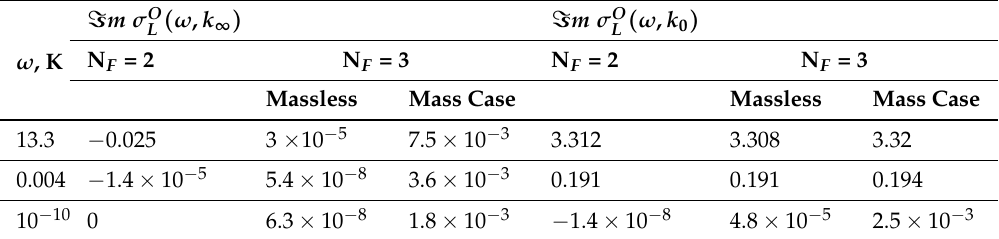
( ω , k ) for the massless pseudo Dirac fermion graphene model is a The function (cid:61) m σ O L (cid:12) ( k ) ≡ (cid:61) m σ constant function (cid:61) m σ O (cid:12) k ∞ at large wave numbers. The L k → ∞ < 0) for the frequencies ω = 0.004, 13.3 K and a zero-values function constant ( (cid:61) m σ k ∞ = 0) at ω = 10 − 10 K (see Table 1 and Figure 4). However, the imaginary part of ( (cid:61) m σ k ∞ the longitudinal complex conductivity in the N F = 2-model becomes a positive constant (cid:12) ≡ (cid:61) m σ > 0 at small values of k , k (cid:28) 1 for the frequencies ω = 0.004, (cid:61) m σ O ( k ) (cid:12) k 0 L k → 0 13.3 K. As the Table 1 and Figure 4 show the function (cid:61) m σ O